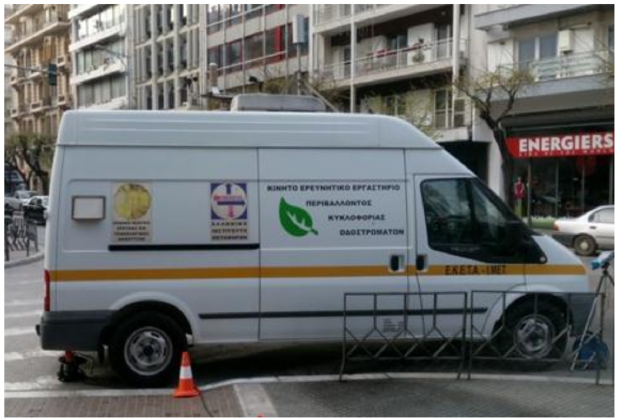
Figure 3. Mobile Lab for Environmental and Traffic Measurements of Centre for Research Technology (CERTH)/Hellenic Institute of Transportation (HIT), equipped with a portable air pollution sensor rack for collecting and analysing environmental pollution and traffic related